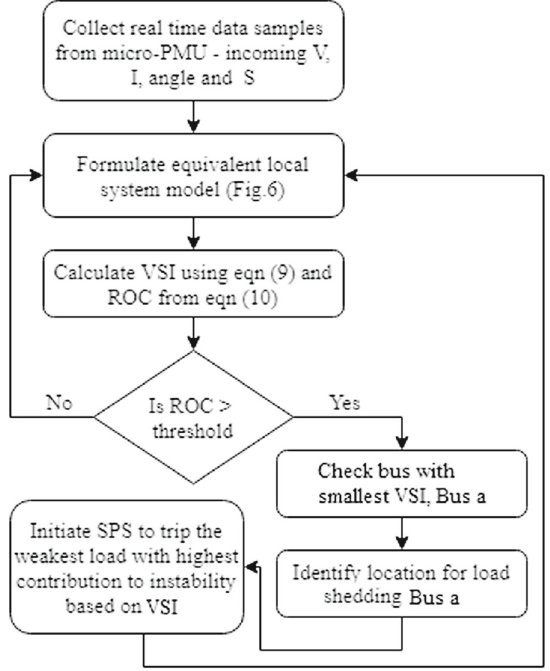
Fig. 8 Flowchart of the proposed scheme